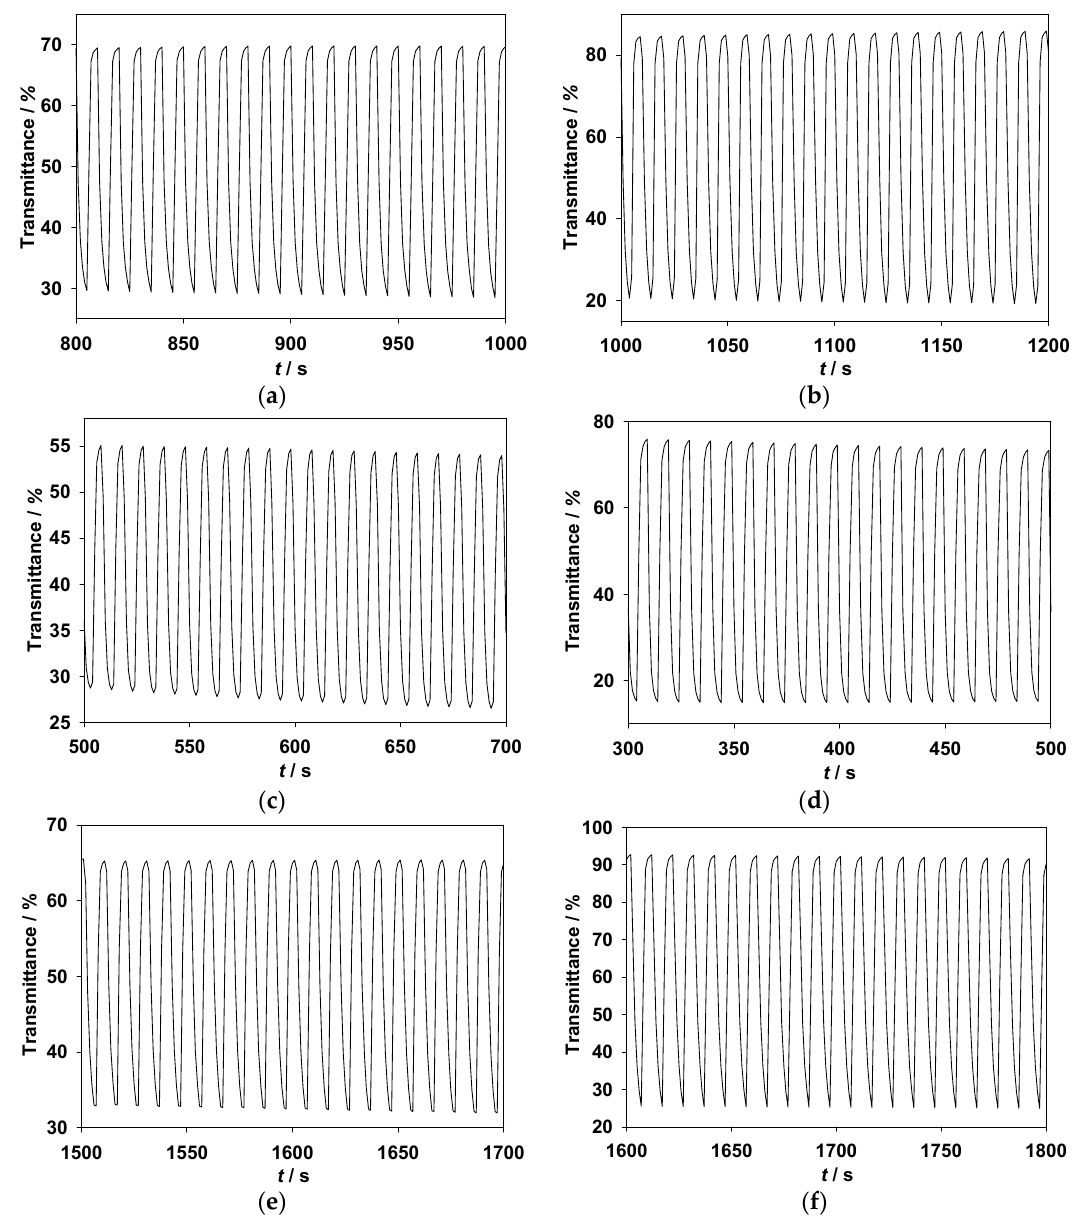
Figure 7. In situ transmittance of ( a ) P(MPS- co -TTPA) at 570 nm; ( b ) P(MPS- co -TTPA) at 964 nm; ( c ) P(MPO- co -TTPA) at 592 nm; ( d ) P(MPO- co -TTPA) at 914 nm; ( e ) P(ANIL- co -TTPA) at 548 nm; and ( f ) P(ANIL- co -TTPA) at 960 nm as a function of time in solution state, with the time interval of 5 s. The copolymer films were stepped by repeated potential between − 0.2 and +0.9 V.